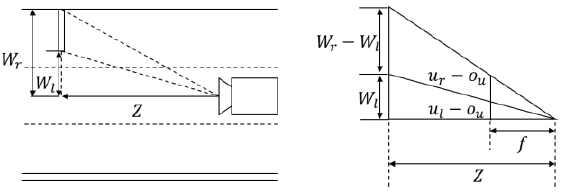
Figure 9. Top-view of road sign, virtual camera and road surface.